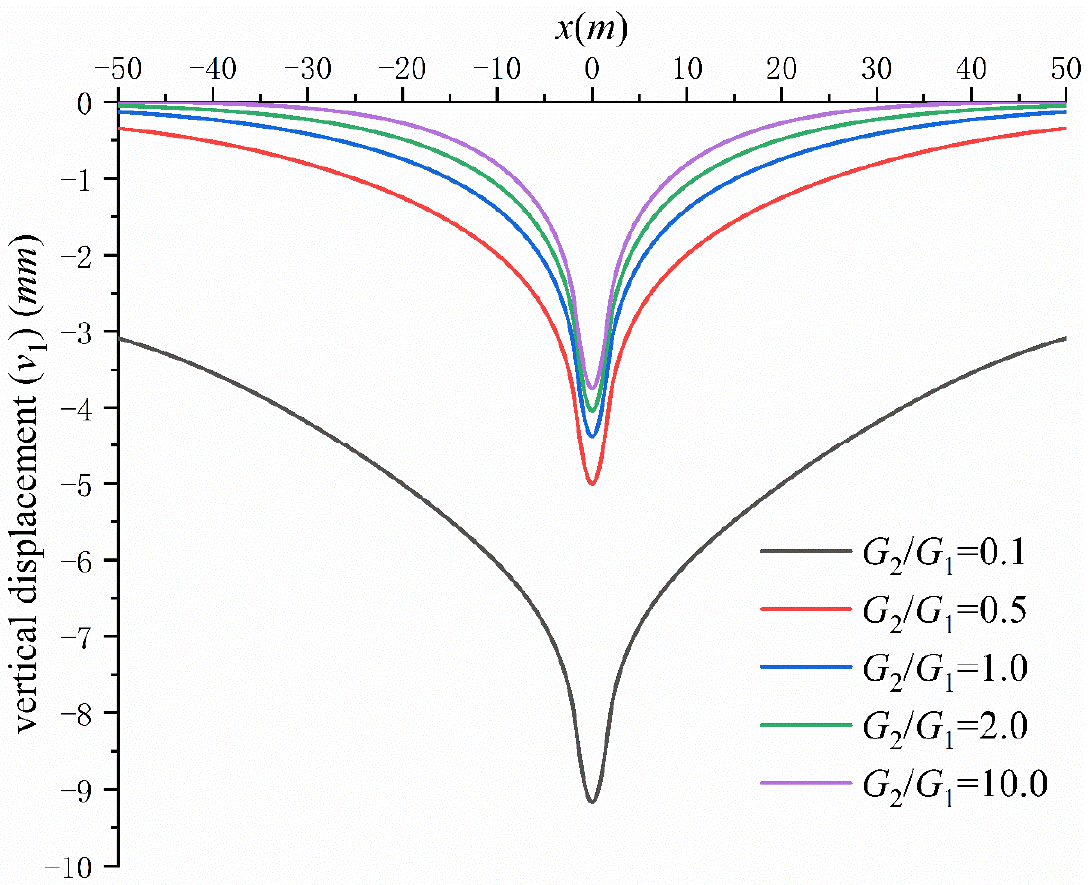
Figure 11. Effect of layered soil on surface settlement.